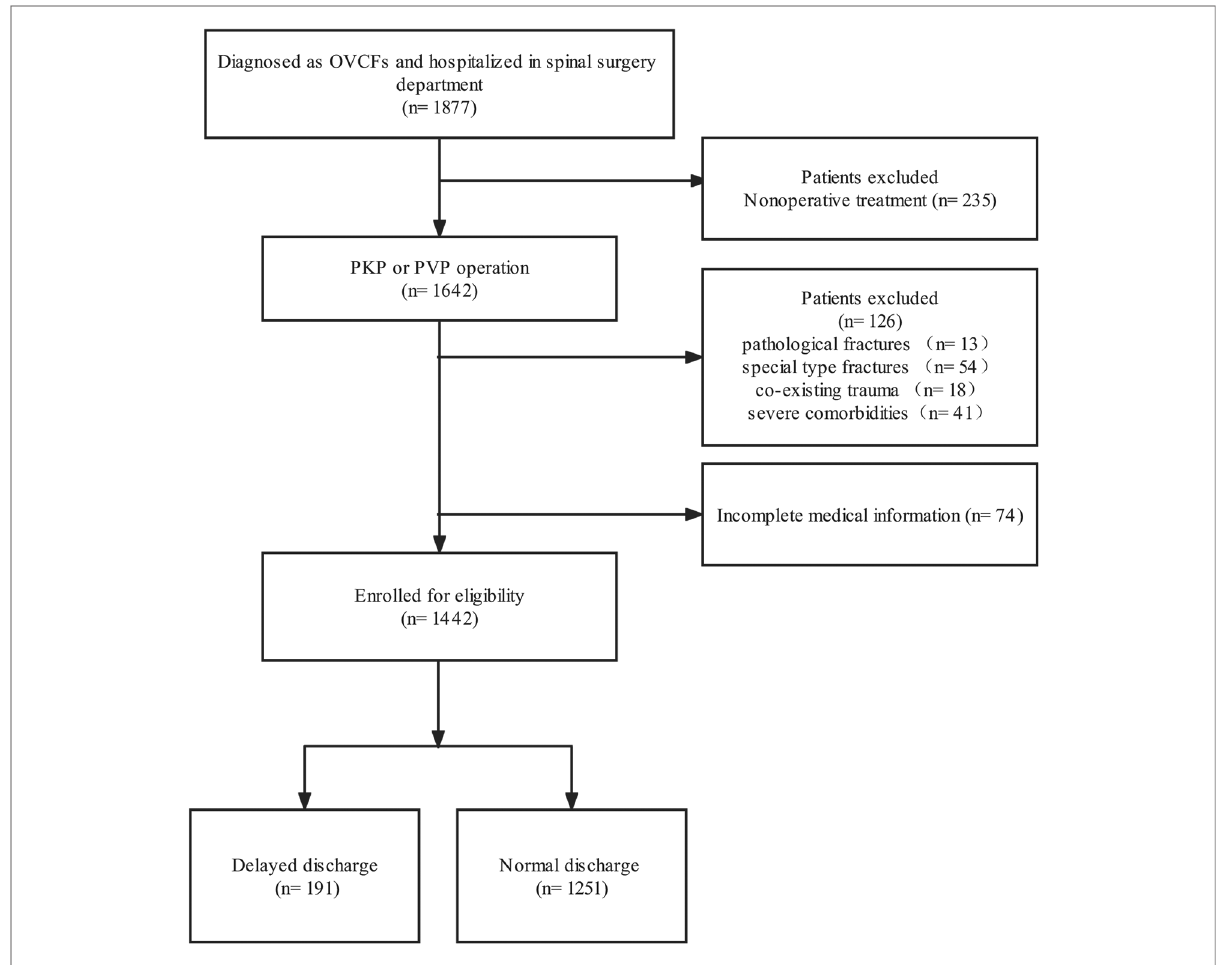
FIGURE 1 Study fl owchart.